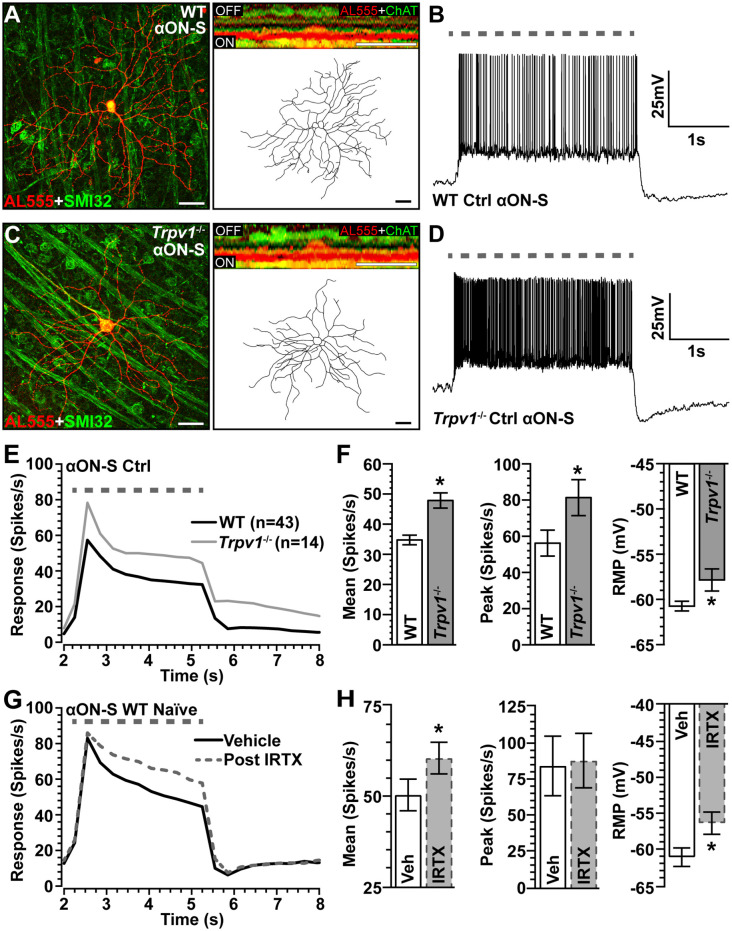
Comparison of WT and Trpv1−/− αON-sustained retinal ganglion cells (RGCs). (A) Confocal micrograph of WT αON-S RGC following intracellular filling with Alexa555 dye (AL555) shows strong localization of non-phosphorylated neurofilament H (SMI32, green). Orthogonal rotation (inset) shows dendrites ramifying narrowly in the ON region of the inner plexiform layer (IPL) relative to the label for choline acetyltransferase (ChAT, green). (B) WT αON-S RGC responds to light (365 nm, 3 s; dashed line) with a sustained train of action potentials during whole-cell current-clamped conditions that preserved resting membrane potential (RMP; 0 pA). (C)
Trpv1−/− αON-S RGC has similar morphology and branching pattern and a more robust sustained response to light (D). When averaged across cells (E,F), the response of Trpv1−/− αON-S RGCs exceeded WT for both mean (53.4 ± 7.7 vs. 35.5 ± 4.8 spikes/s; *p < 0.001) and peak firing rate (81.4 ± 9.9 vs. 56.2 ± 7.2 spikes/s; *p = 0.02), with more depolarized (RMP; −57.9 ± 1.1 mV vs. −60.6 ± 0.6 mV, *p = 0.03). (G,H) For naïve WT αON-S RGCs (n = 7), bath application of IRTX (100 nM) significantly increased the mean light response histogram (+40%; *p < 0.001) and depolarized the RMP (*p = 0.009). Peak response was unaffected (p = 0.77). WT control group contains 14 cells from naïve eyes and 29 cells from saline-injected eyes. (A,C) Scale bar = 40 μm. Statistics: Student’s t-tests (F), paired t-tests (H). Data = mean ± SEM.